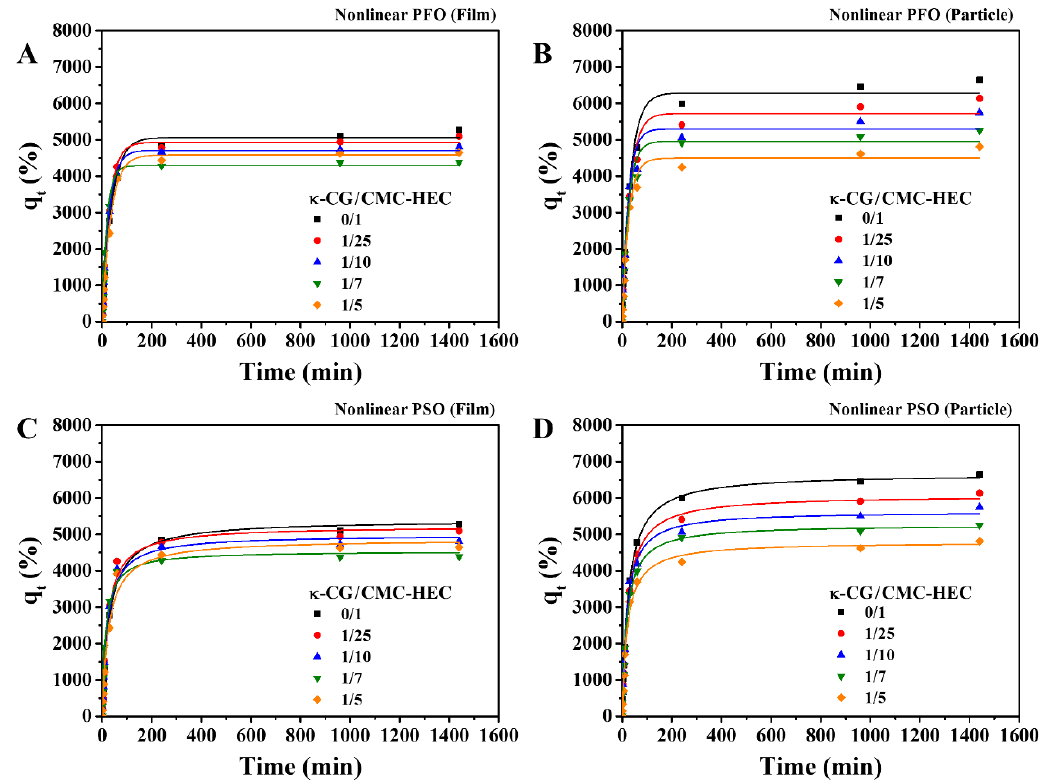
Figure 8. Effect of the absorption time on the water ‐ absorption capacity of the hydrogel films and particles with different compositions in deionized water (pH 7) at 25 °C. The experimental data were fitted with the ( A , B ) nonlinear PFO and ( C , D ) PSO kinetic models. Table 2. Kinetic ‐ model parameters obtained using the linearized PFO and PSO models for the water absorption onto the dried gels in deionized water (pH 7) at 25 °C.